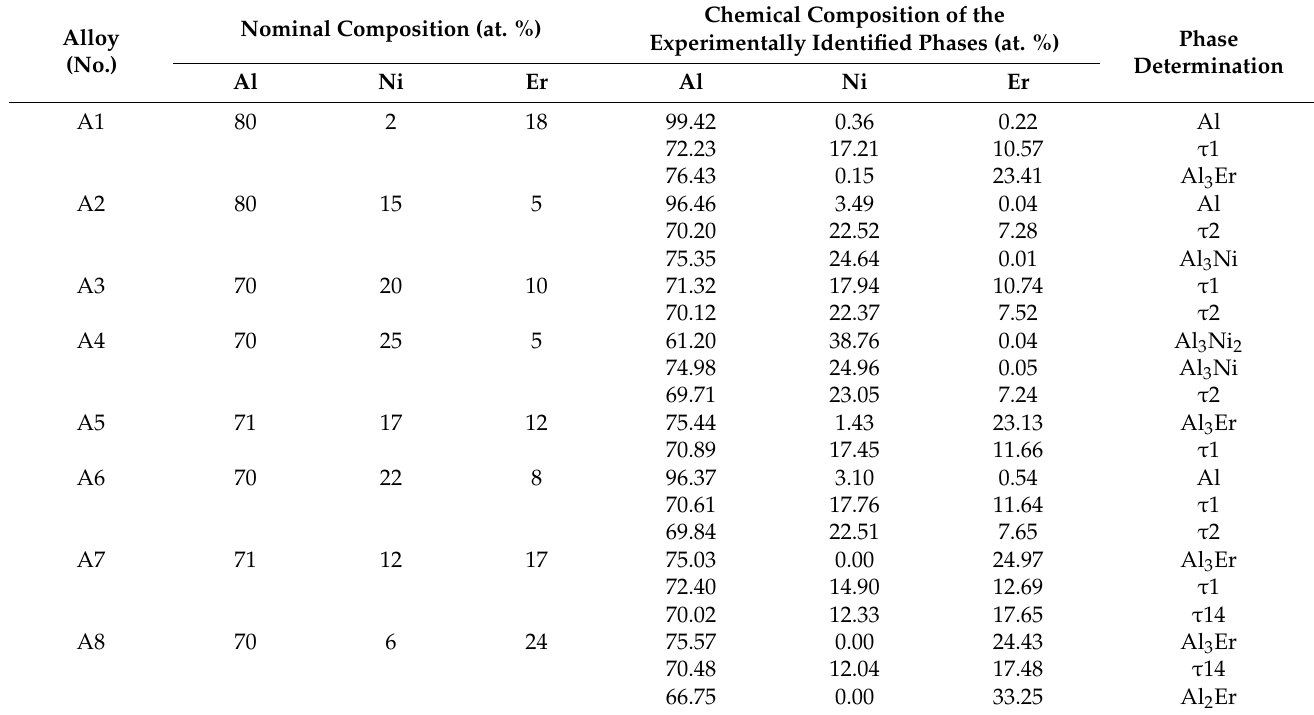
Table 2. Constituent phases and compositions in the annealed Al–Ni–Er alloys at 600 ◦